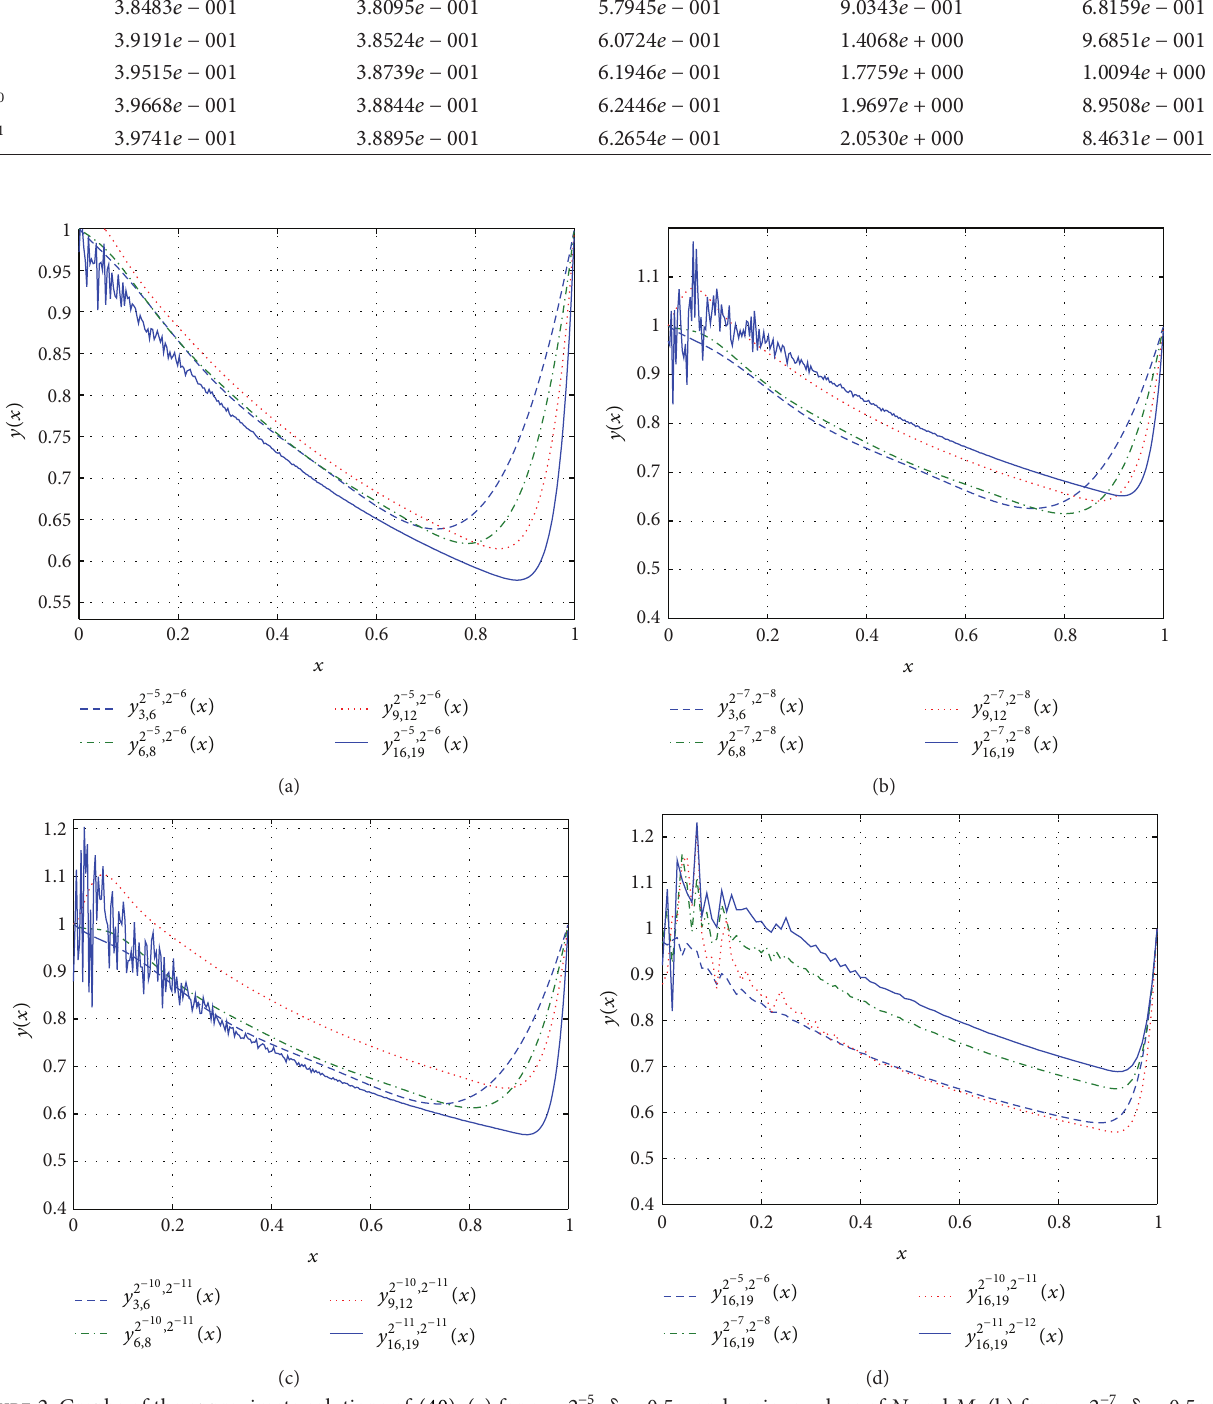
Figure 2: Graphs of the approximate solutions of (40), (a) for 𝜀 = 2 −5 , 𝛿 = 0.5𝜀 , and various values of 𝑁 and 𝑀 , (b) for 𝜀 = 2 −7 , 𝛿 = 0.5𝜀 , and various values of 𝑁 and 𝑀 , (c) for 𝜀 = 2 −10 , 𝛿 = 0.5𝜀 , and various values of 𝑁 and 𝑀 , and (d) for 𝜀 = 2 −5 , 2 −7 , 2 −10 , and 2 −11 , 𝛿 = 0.5𝜀 , 𝑁 = 16 , and 𝑀 = 19